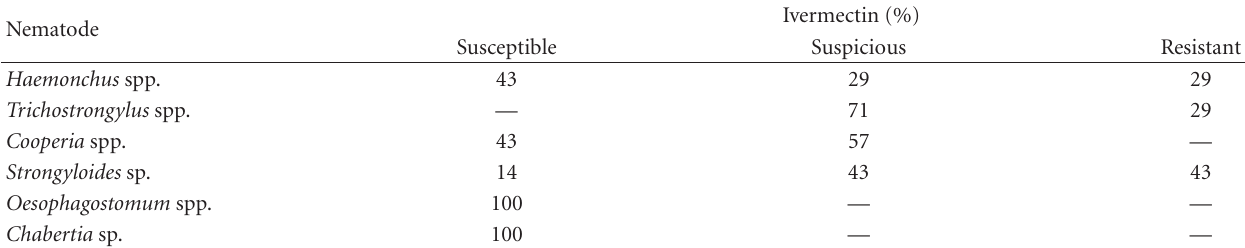
Table 3: Anthelmintic resistance (%) to albendazole in gastrointestinal nematodes of sheep flocks in Costa Rica. Albendazole Nematode (# farms) Susceptible Suspicious Resistant Haemonchus spp. (7) 29 — 71 Trichostrongylus spp. 14 43 43 Cooperia spp. 57 14 29 Strongyloides spp. — 43 57 Oesophagostomum spp. 100 — — Chabertia sp. 86 14 — Table 4: Anthelmintic resistance to ivermectin in gastrointestinal nematodes of sheep flocks in Costa Rica. Ivermectin (%) Nematode Susceptible Suspicious Resistant Haemonchus spp. 43 29 29 Trichostrongylus spp. — 71 29 Cooperia spp. 43 57 — Strongyloides sp. 14 43 43 Oesophagostomum spp. 100 — — Chabertia sp. 100 —